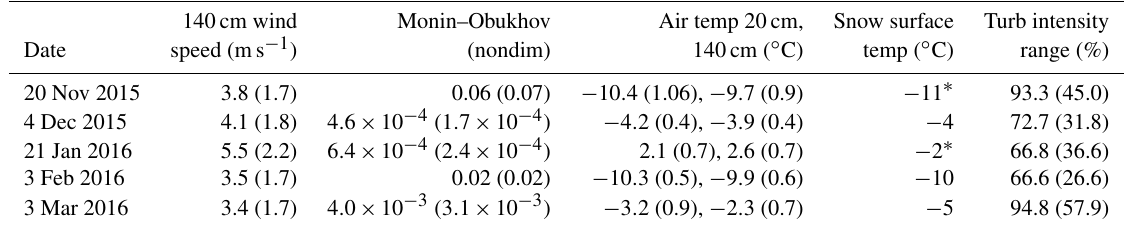
Table 1. Meteorological Variables for five nights of observations. ∗ Snow surface temperature taken from the nearby Powerline meteorolog- ical